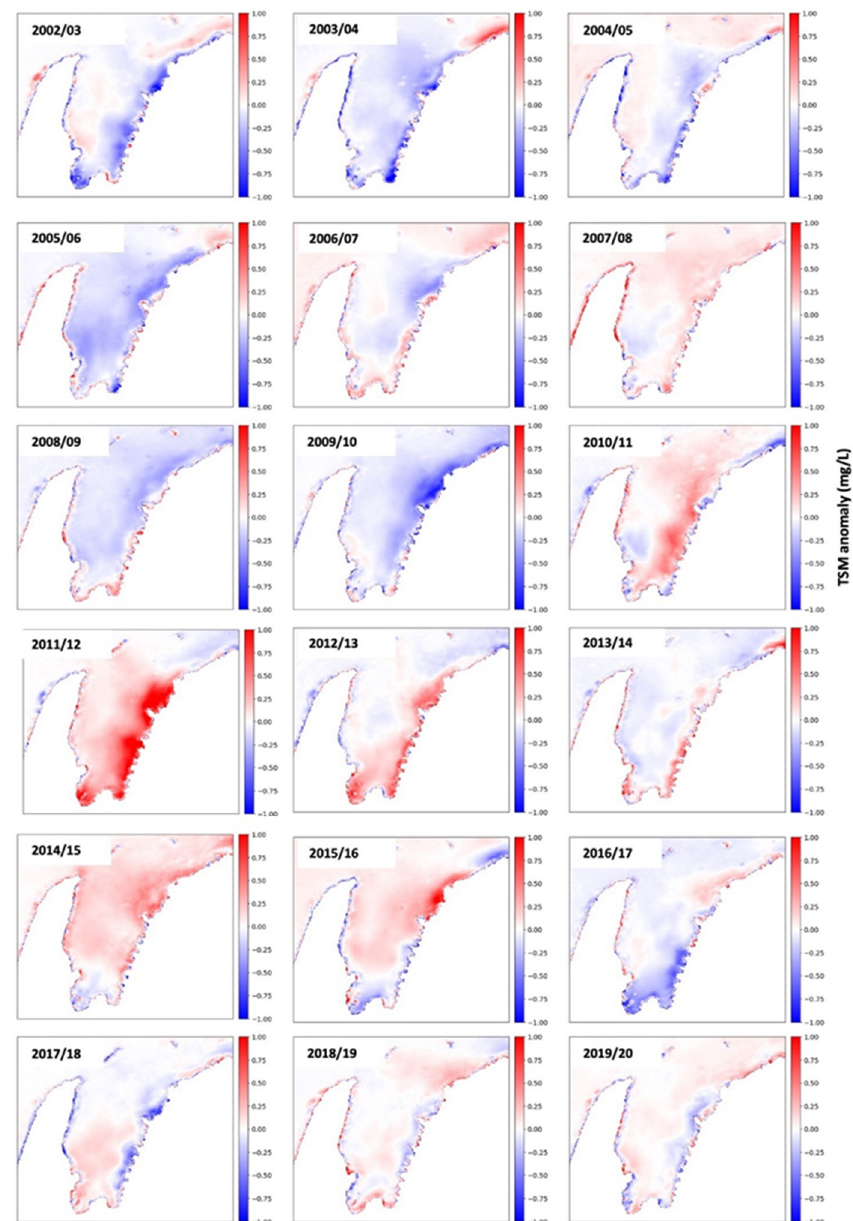
Figure 3. Anomaly maps showing the years 2002–2020 (1 July–30 June) where mean turbidity is higher (red) or lower (blue) than the overall mean turbidity for the entire period.